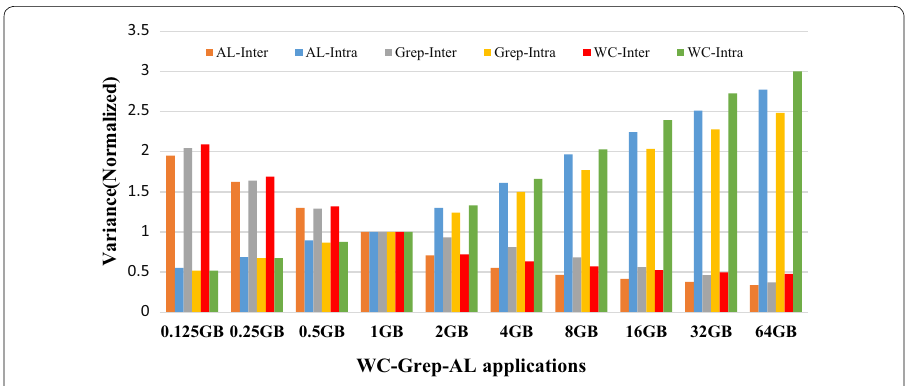
Fig. 14 Impact of block size on the intra/inter variance (NoSQL datasets)